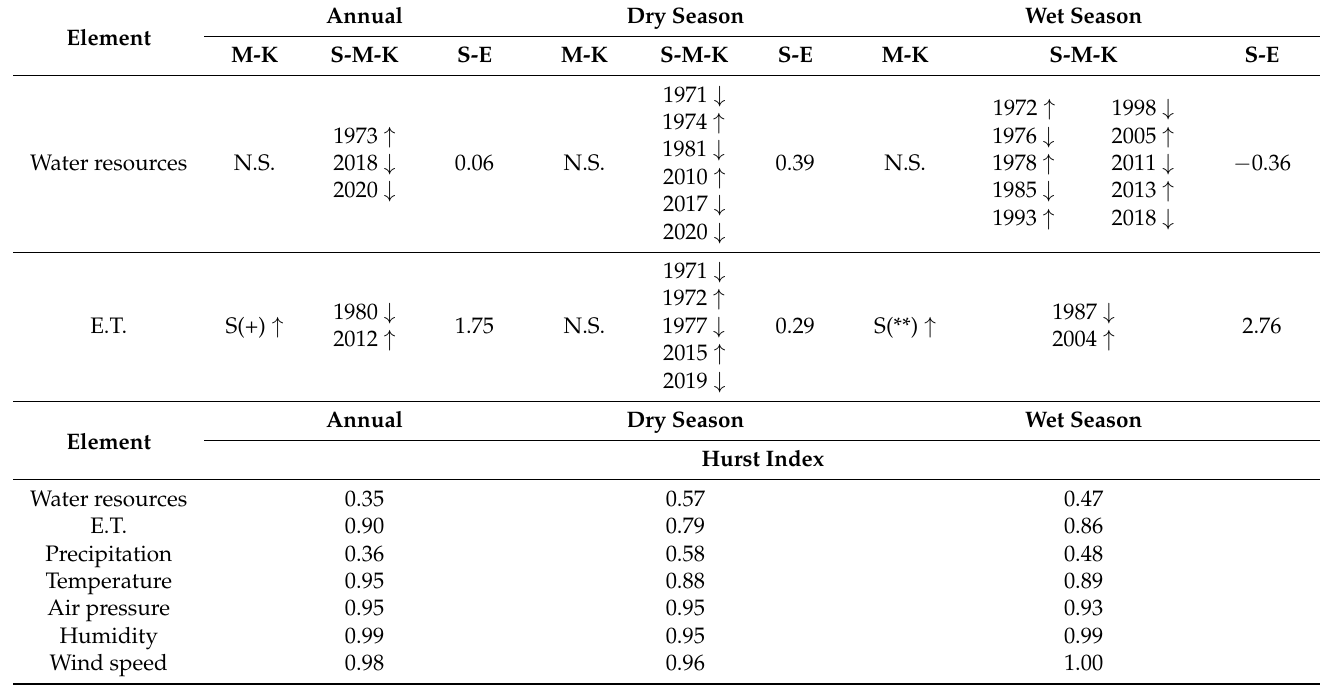
Table 2. M-K test, S-M-K test, S-E test and Hurst index of each element from 1970 to 2020.